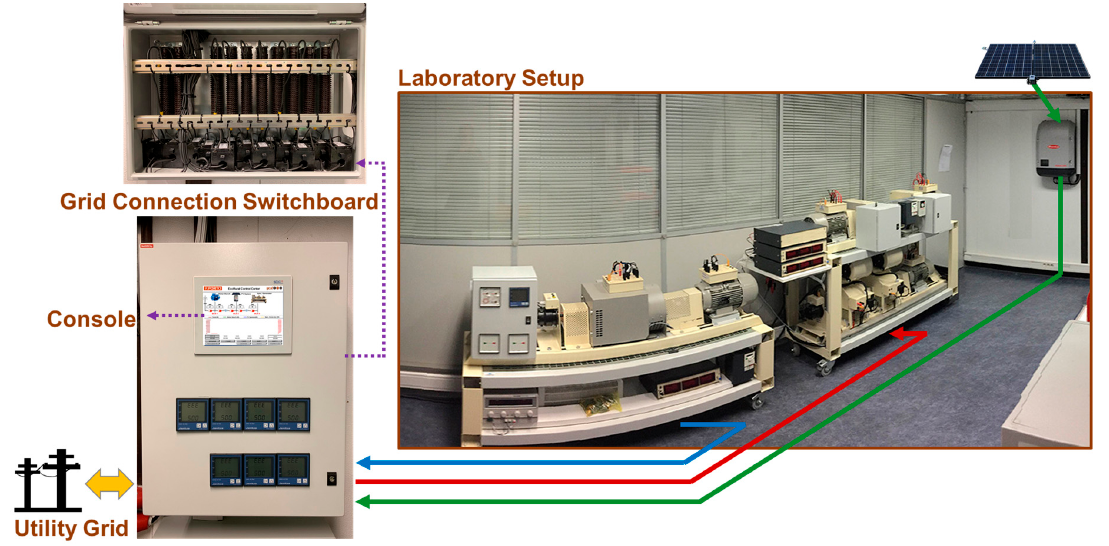
Figure 4. Internal electricity network of the presented system.